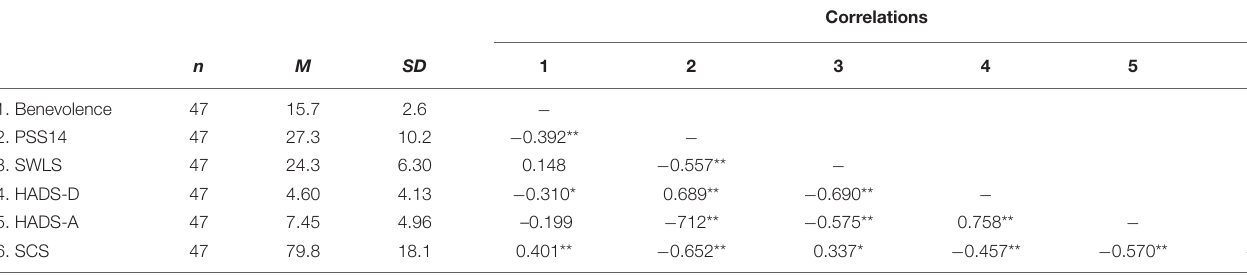
TABLE 2 | Study 2: Descriptive statistics and correlations.